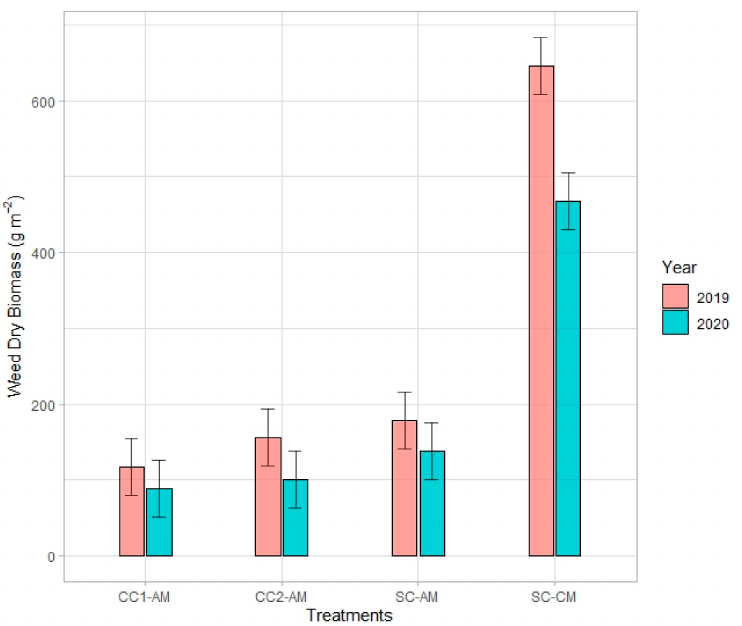
Figure 4. Effect of treatments (CC1-AM, CC2-AM, SC-AM, SC-CM) and years on weed dry biomass. Error bar represents the upper and lower limits of the 95% confidence